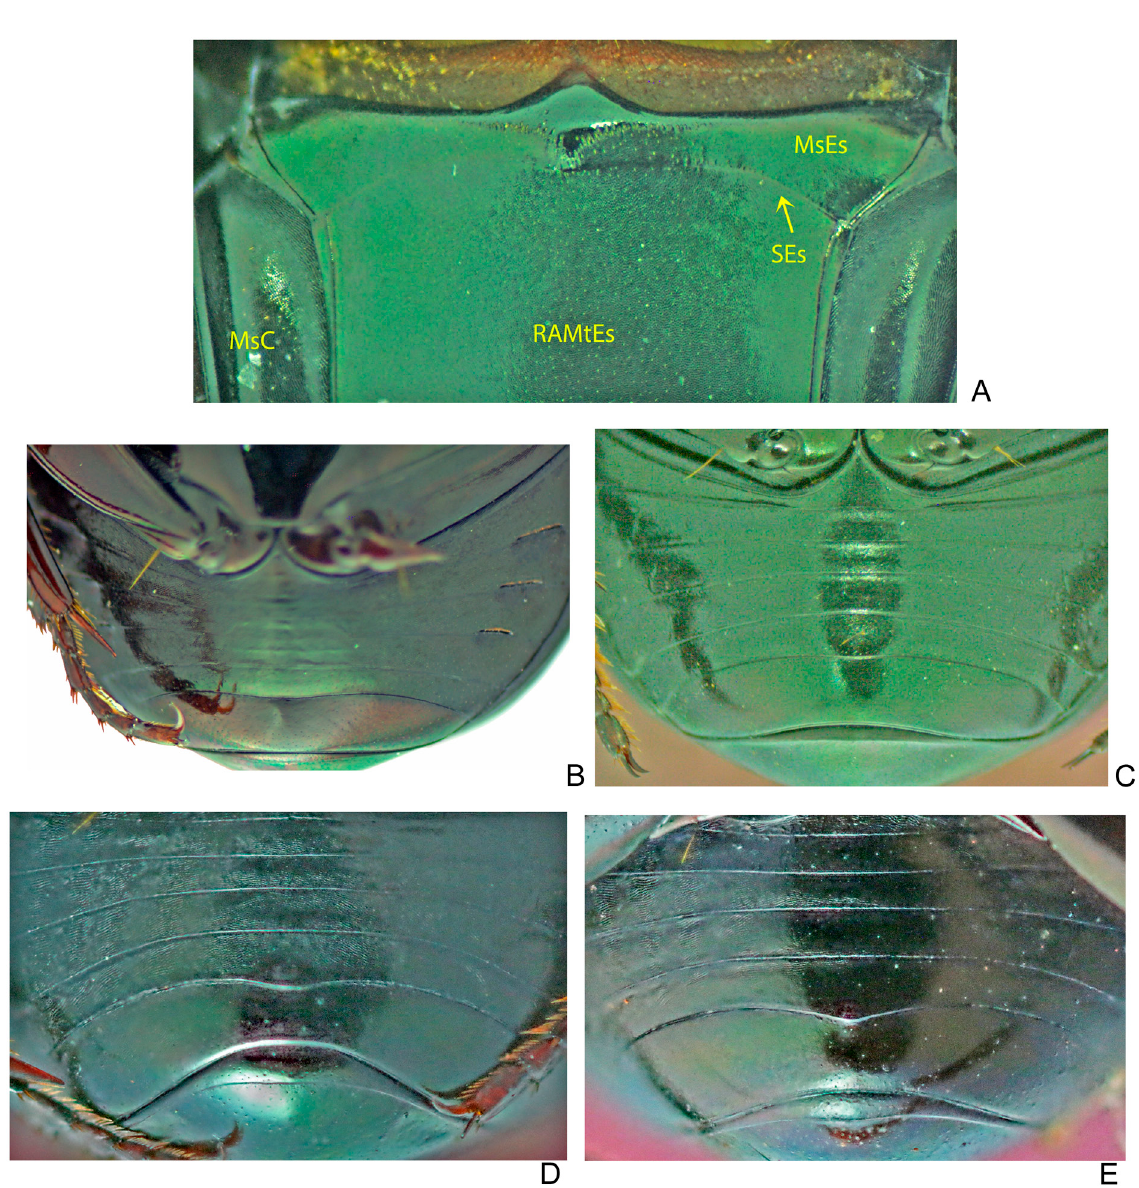
Fig. 14. A . Ventral view of the anterior region of the pterothorax of S. proseni (Martínez, 1949) stat. et comb. nov. Abbreviations: MsEs = mesoventrite; SEs = meso-metaventrite suture; MsC = mesocoxa; RAMtEs = anterior region of metaventrite. B–E . Sexual dimorphism in the abdominal ventrites of Sylvicanthon Halffter & Martínez, 1977. B . S. foveiventris (Schmidt, 1920), ♀ . Note the three lateral foveae between ventrites I–II, II–III, and III–IV and the broad ventrite VI at the middle, without emargination on its posterior edge and without its anterior edge covered by a medial flange of ventrite V. C . S. proseni stat. et comb. nov. , ♀, ventrite VI broad. D . S. candezei (Harold, 1869), ♂. Note how the ventrite VI is narrow at the middle due to the emargination on its porterior edge and to the medial flage of the posterior edge of the ventrite V. E . S. candezei (Harold, 1869), ♀. Despite its posterior edge not being emarginate, its anterior edge is covered by a well-developed medial flange of ventrite V, which gives a narrowed aspect to the centre of ventrite